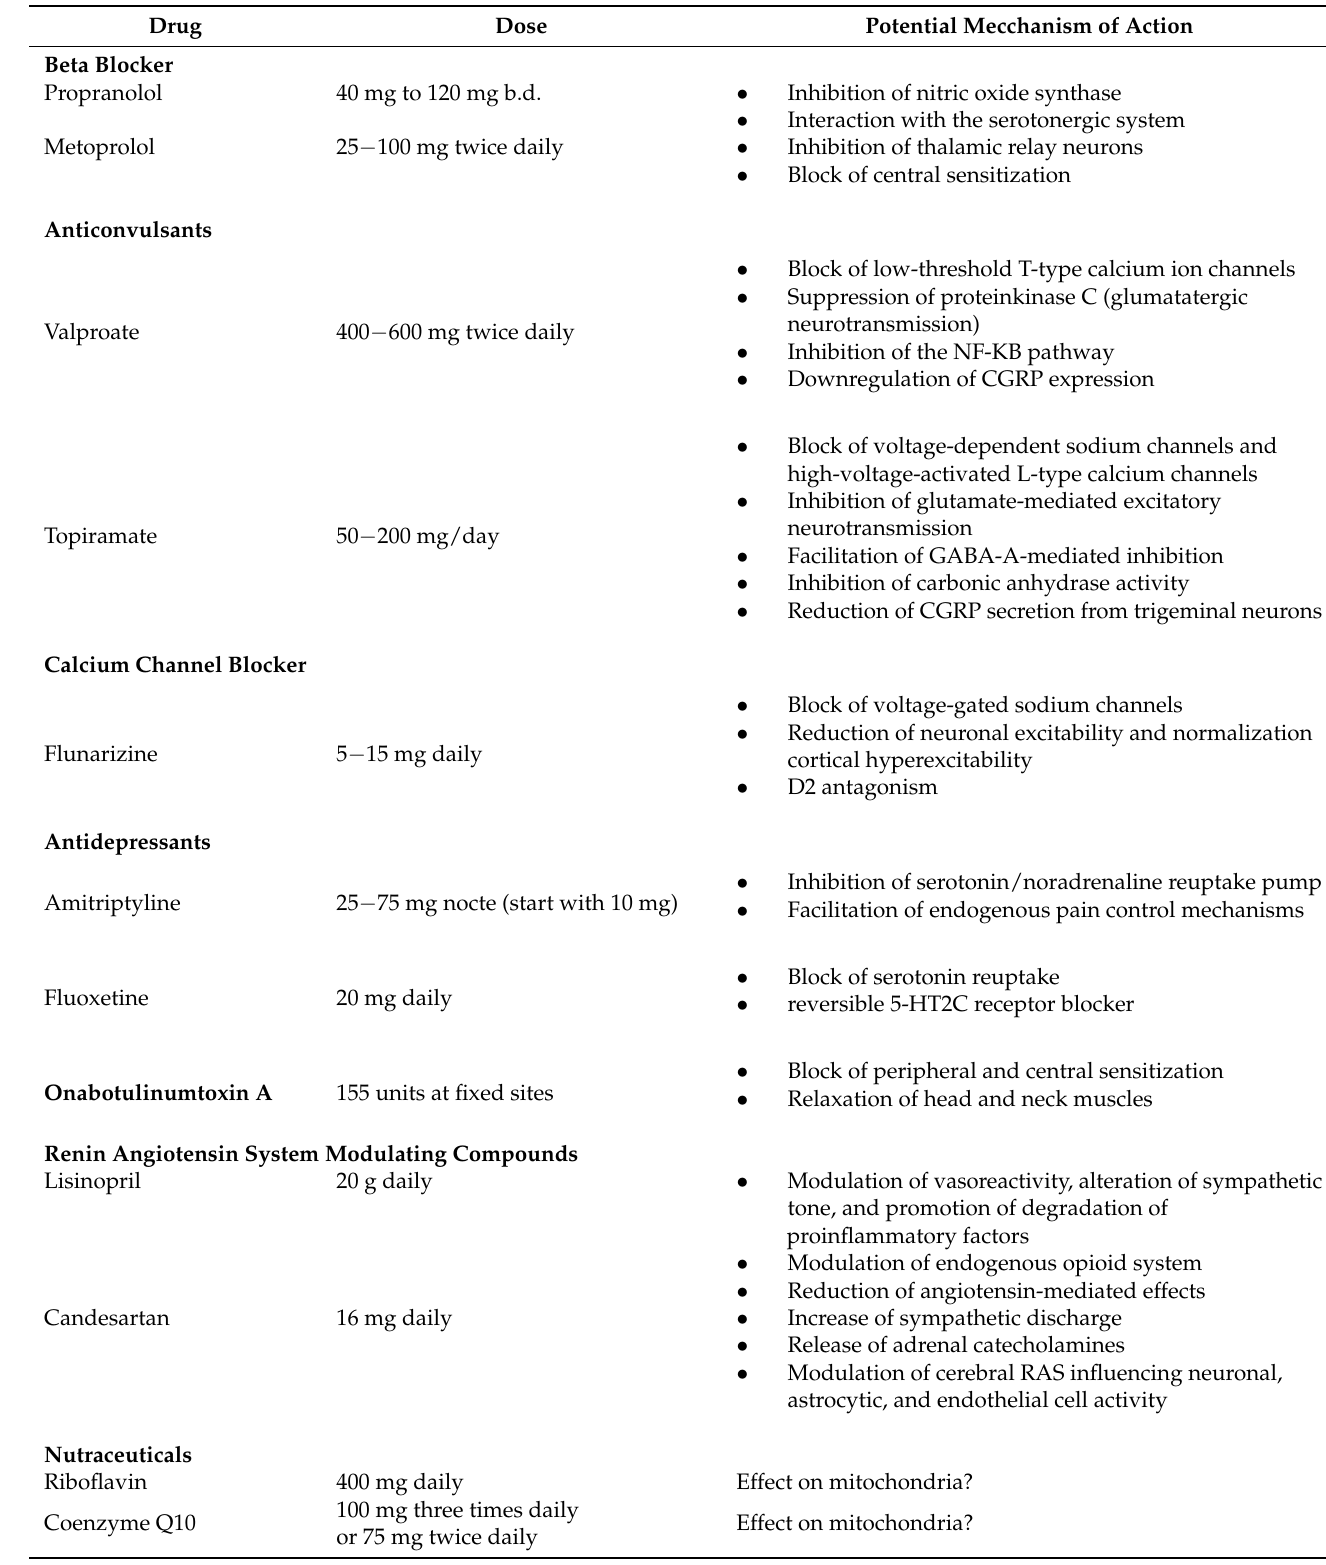
Table 1. Therapeutic options: in this table are indicated drugs, posology and their